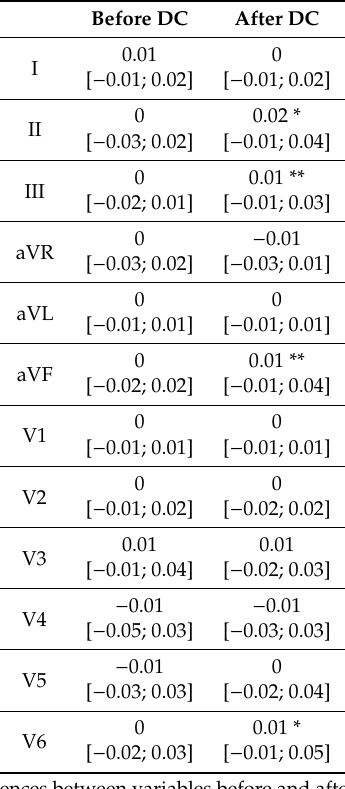
Table 2. Changes in STJ segment after compared to before decompressive craniectomy (DC). Before DC